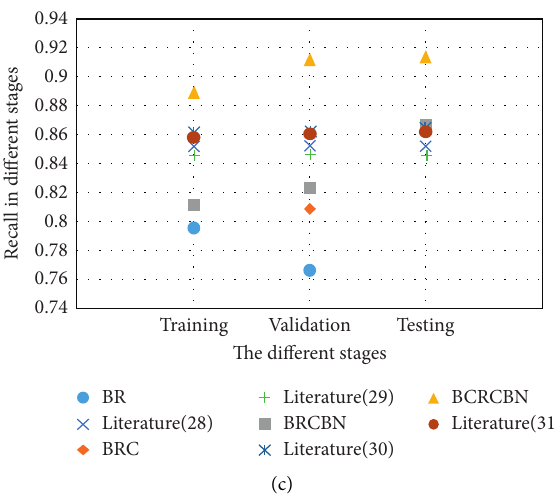
Figure 6: Results of named entity recognition in WSJ corpus for different network structures.